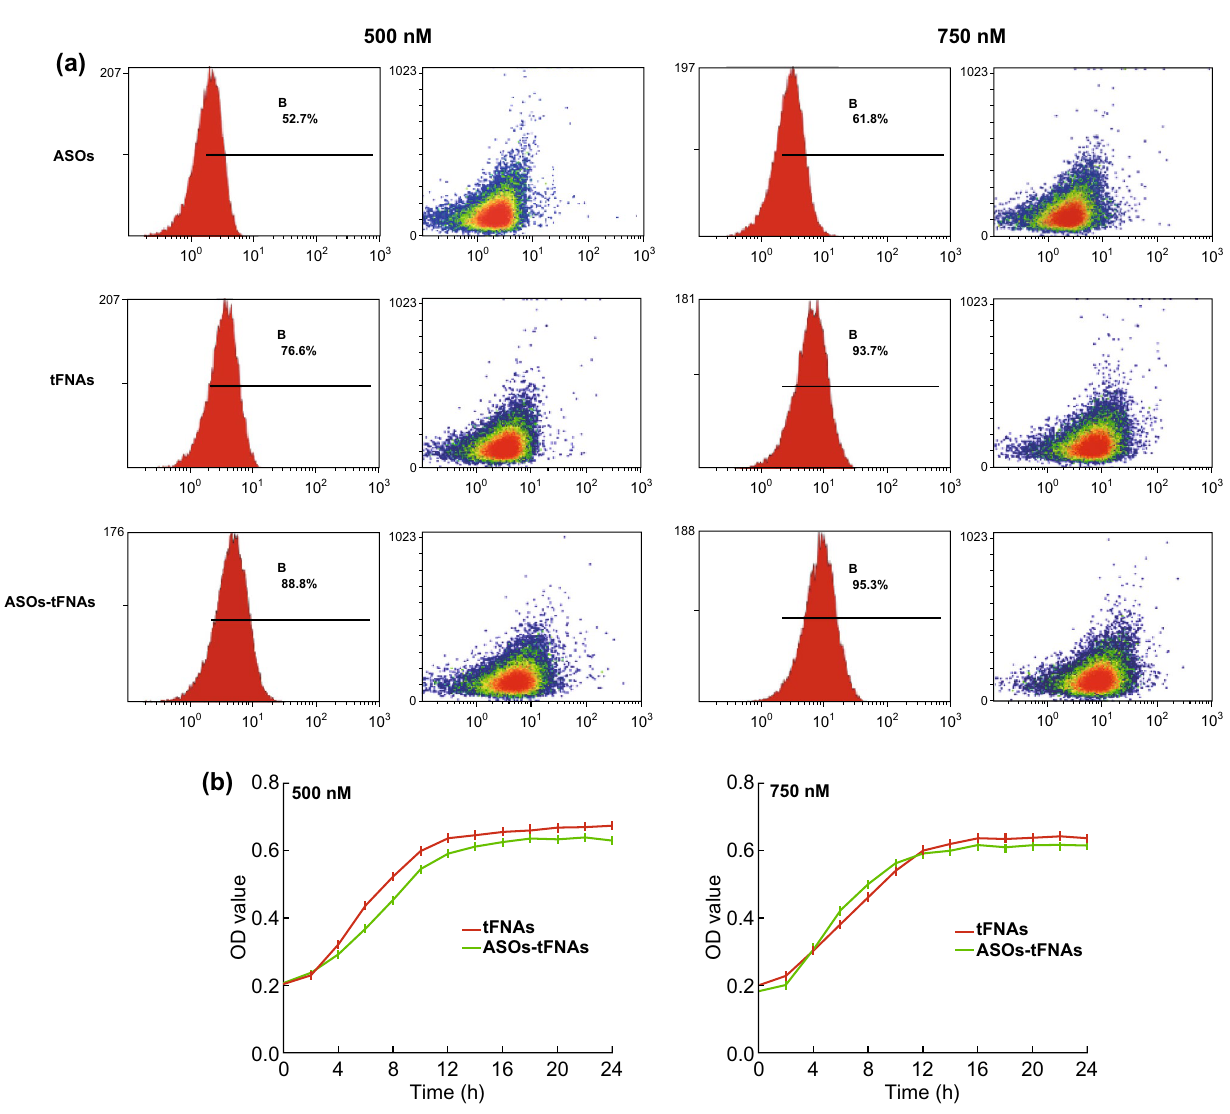
Fig. 2 ASOs-tFNAs are successfully taken up by S. mutans biofilms. a Flow cytometry analysis of the uptake rates by S. mutans incubated in the presence of different concentrations of Cy5-labeled ASOs, tFNAs, and ASOs-tFNA for 12 h, b effect of tFNAs and ASOs-tFNAs on growth of planktonic S. mutans cells at different concentrations of tFNAs or ASOs-tFNAs. Values represent the mean ± SD ( n =